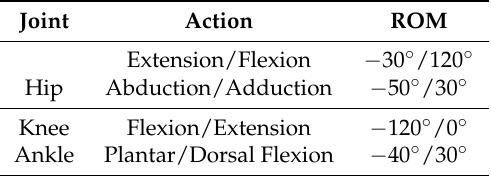
Table 1. Joints and Range of Motion